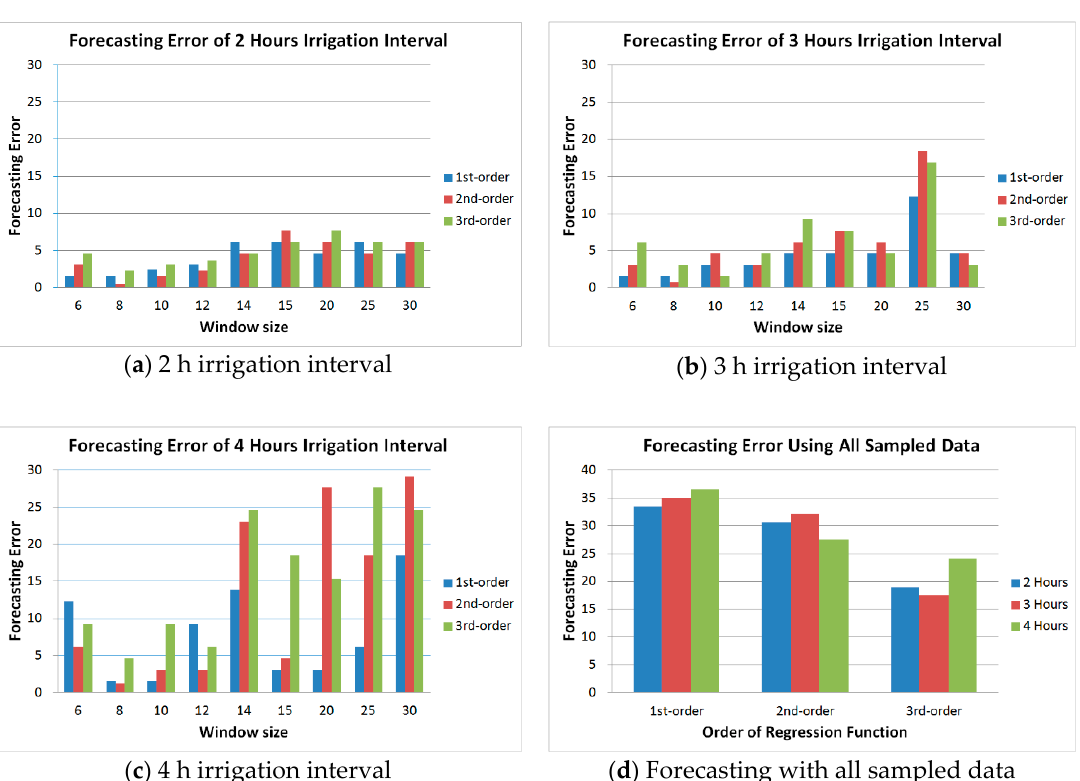
Figure 6. The forecasting accuracy of different window sizes. The sensors placed at the 3 cm depth layers of soil. The forecasting error is estimated in moisture levels. The dimension of moisture level is 0–1023. ( a ) The results of the forecasting error by using the 2 hours irrigation interval. ( b ) The results of 3 hours irrigation interval. ( c ) The results of 4 hours irrigation interval. ( d ) The results of using all the sampled data.